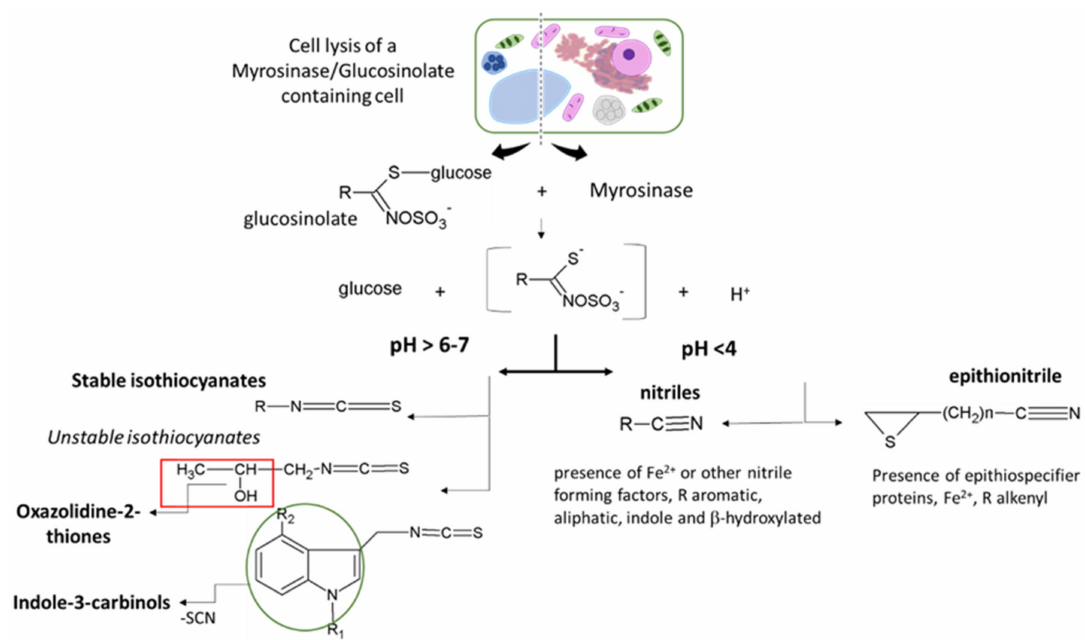
Figure 3. Glucosinolate hydrolysis products reactivity according to the structure of the glucosinolate side chain (R), the presence of supplementary specifier proteins, and/or the physiochemical reaction